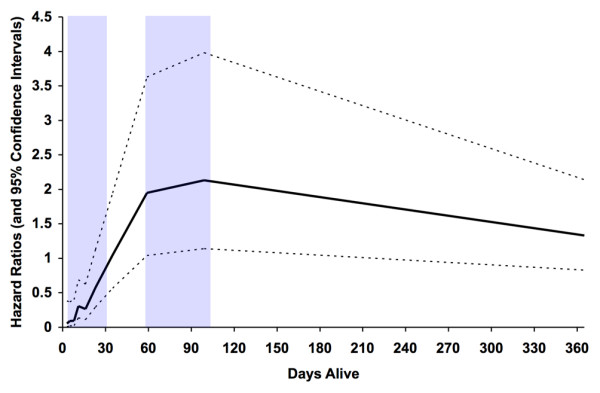
Hazard ratios for prolonged mechanical ventilation status over one year of follow up. Plot of hazard ratios (solid line) and 95% confidence intervals (dashed lines) for DRG 541/542 patients versus short-term mechanical ventilation patients, determined using a time-varying piecewise-constant nonproportional survival model. The shaded areas represent time periods with statistically significant hazard ratios. The hazard ratios vary over time, predicting an early (< 30 days after intubation) lower risk for death for DRG 541/542 relative to short-term ventilation patients, but a higher risk for mortality between days 60 and 100 as the slope of short-term ventilation mortality levels off (also see Figure 2). Hazard ratios are adjusted by day one APS, pre-admission Charlson score, age, and pre-admission ADLs. APS, Acute Physiology Score; ADL, activity of daily living; DRG, diagnosis related group.